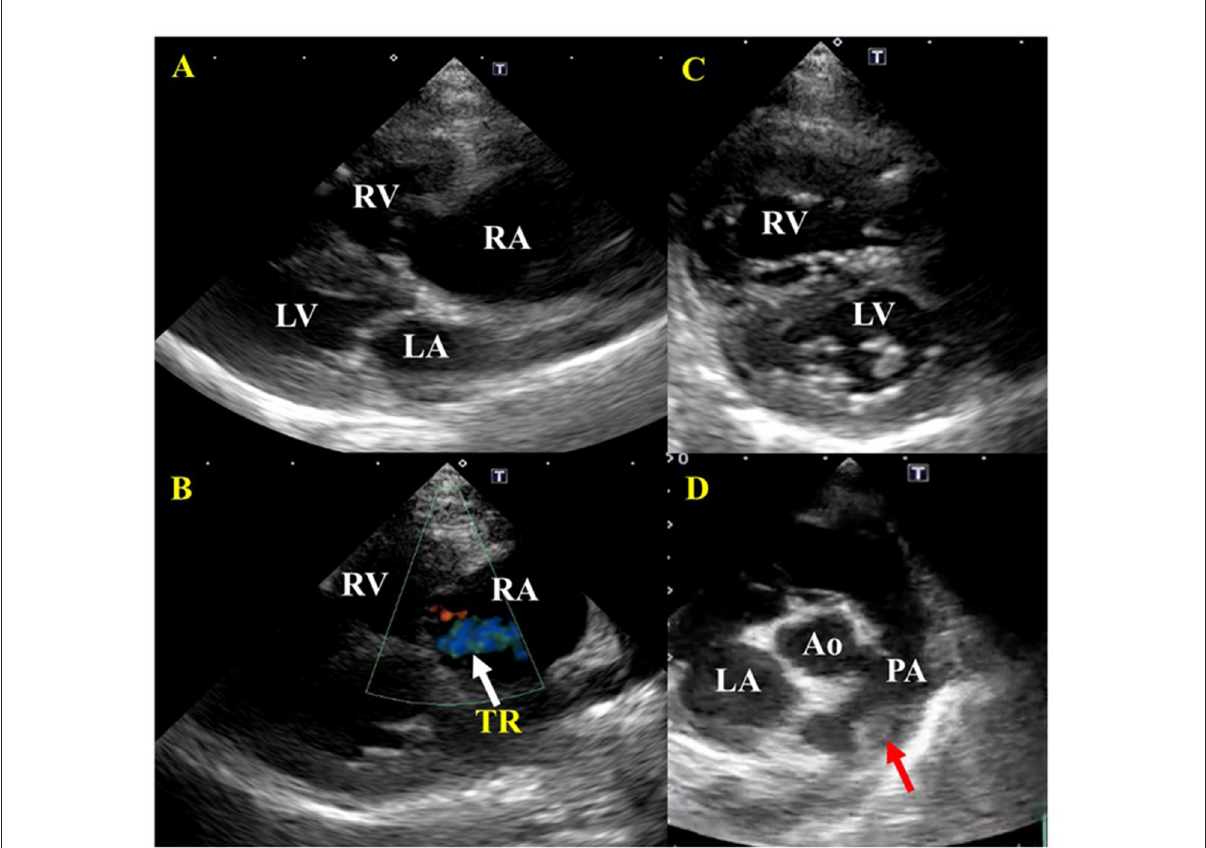
FIGURE3 Echocardiographic images before treatment of a cat diagnosed with IMHA and pulmonary thromboembolism. (A) Right parasternal long-axis view. Enlargement of the right atrium and right ventricle were found. There was no dysplasia of the tricuspid valve, patent ductus arteriosus, atrial septal defect, or ventricular septal defect. (B) Right parasternal long-axis view (Color Doppler imaging). Tricuspid regurgitation was recognized. (C) Right parasternal short-axis view (Apical level). The flattening of the interventricular septum was observed. (D) Right parasternal short-axis view (Basal level). A thrombus was found between the main pulmonary artery and the bifurcation of the right and left pulmonary arteries. RA, right atrium; RV, right ventricle; LA, left atrium; LV, left ventricle; PA, pulmonary artery. Red arrows indicate a thrombus; white arrows indicate tricuspid regurgitation